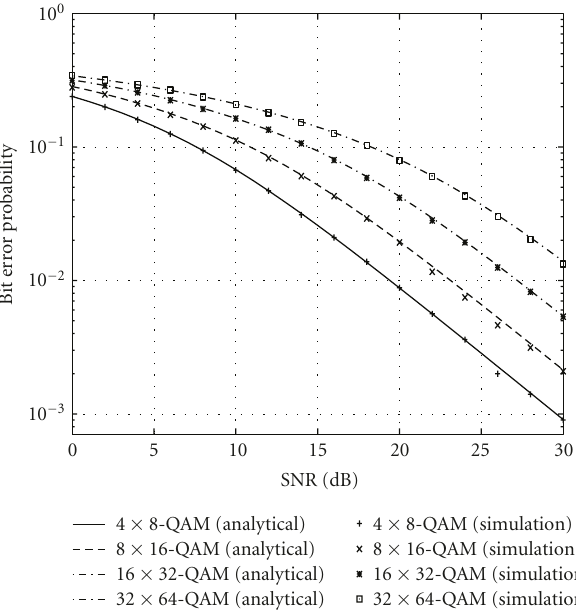
Figure 8: BEP for 16 × 32-QAM subject to Nakagami- m fading for di ff erent values of m , ranging from 0.51 to 0.80.